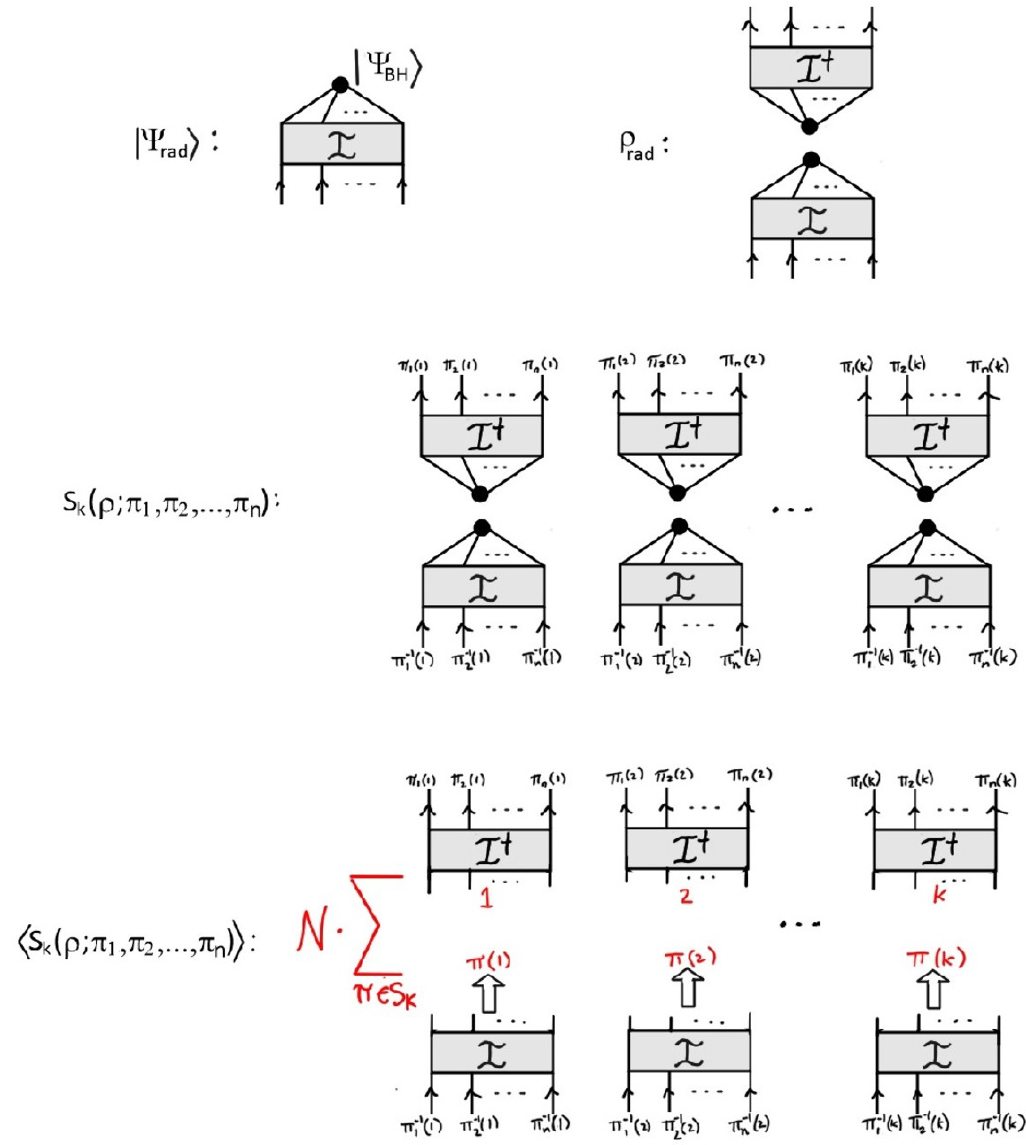
Figure 4 . Diagrammatic representation of j (cid:9) rad i (simpli(cid:12)ed from (cid:12)gure 2), (cid:26) rad = j (cid:9) rad ih (cid:9) rad j , the general invariant S k ( (cid:26) ; (cid:25) 1 ; (cid:1) (cid:1) (cid:1) ; (cid:25) n ), and the same invariant averaged over initial black hole states. The normalization factor is N = (cid:0)( d n ) = (cid:0)( d n + k